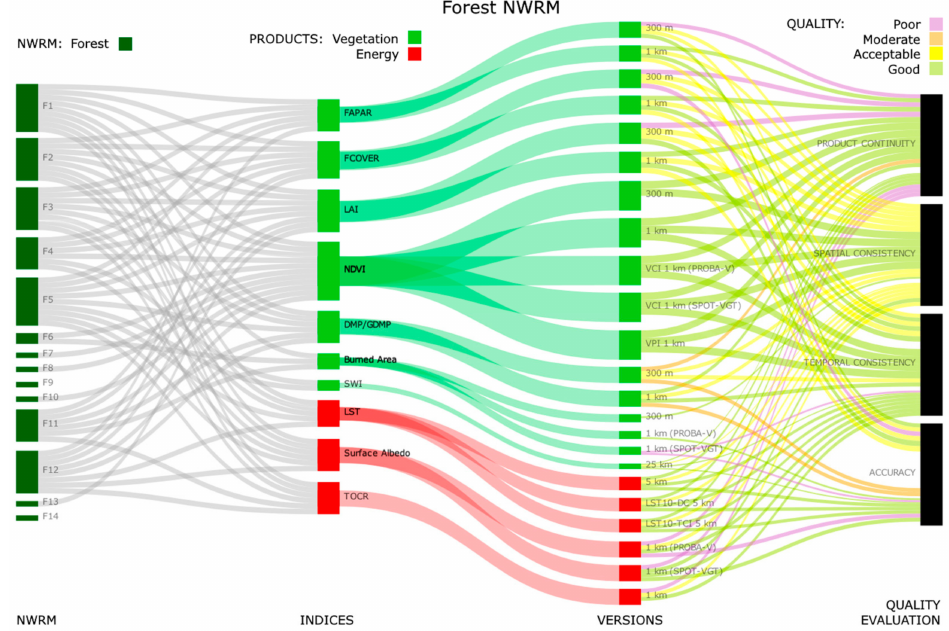
Figure A2. Sankey diagram linking the forest NWRM (F) and the CGLS vegetation and energy indices that are suitable for their monitoring, according to previous research